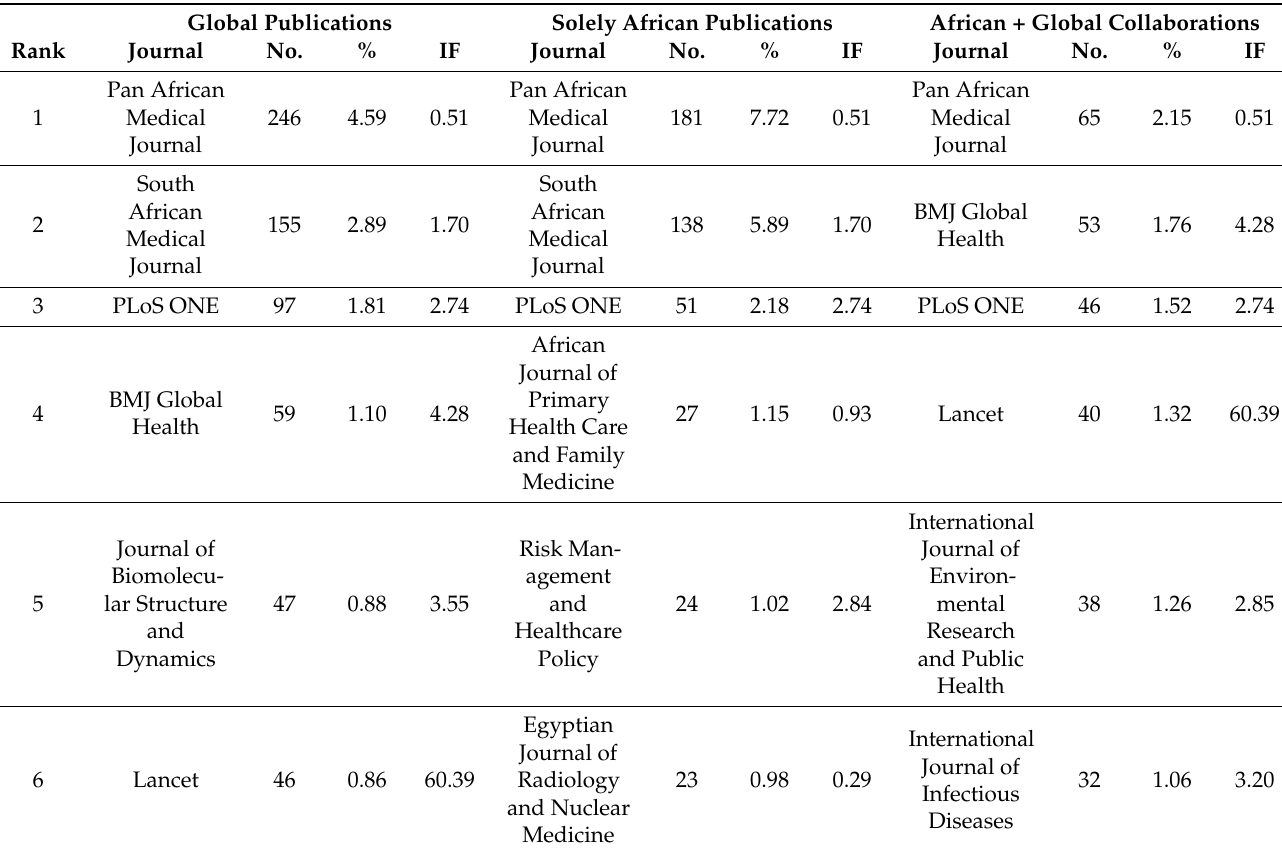
Table 4. Top 15 active journals publishing research papers on COVID-19 in Africa. IF represents the impact factor of the journal and % the percentage. Solely African Publications African + Global